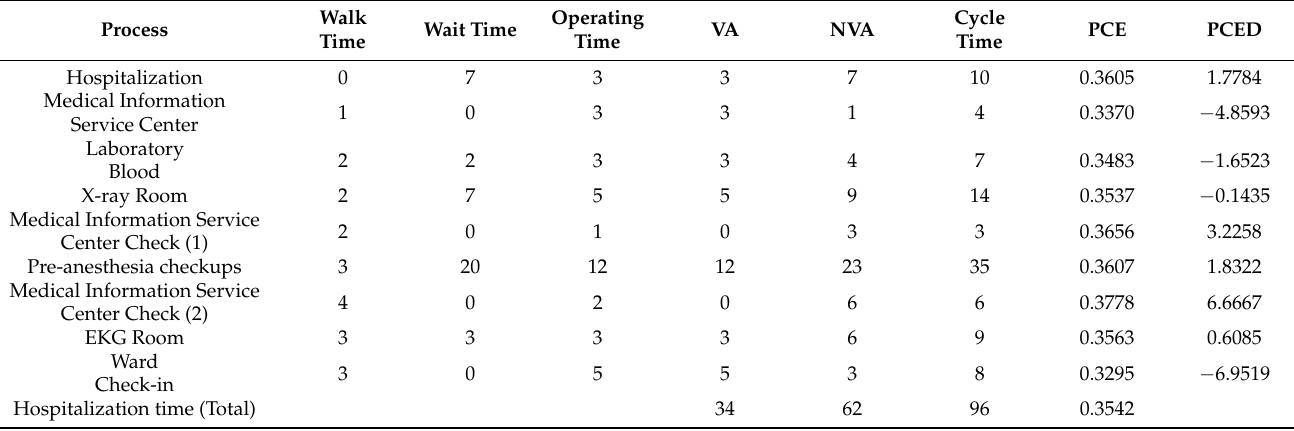
Table 4. Process-cycle loss-efficiency analysis